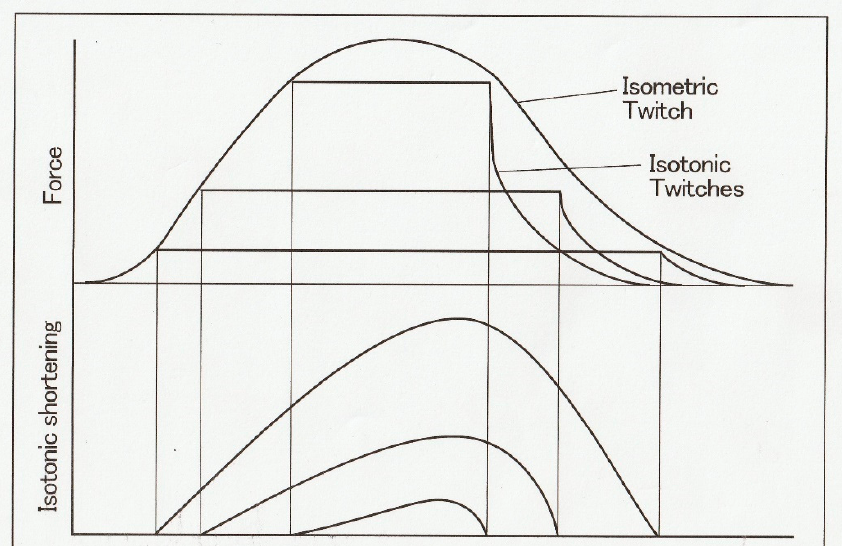
Figure 2. Force (upper traces) and length (lower traces) changes of a muscle during twitches under three different afterloads. The muscle first develops isometric force, and when the force reaches the value equal to the afterload, it starts shortening under the constant afterload with a constant velocity.